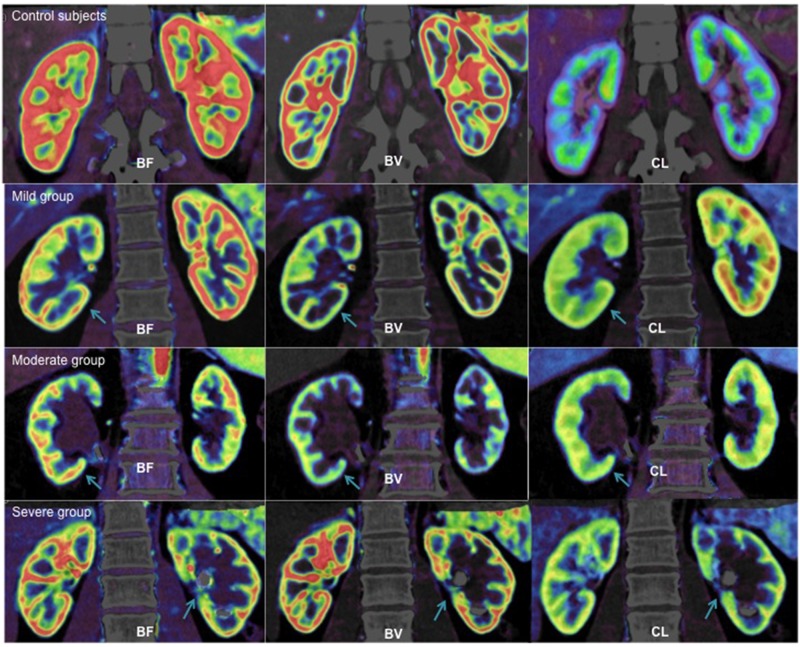
BF, BV and CL maps from control subjects and the three groups of UUO.The perfusions of both kidneys were uniform in control subjects and renal cortex showed an intact red ring. For UUO patients, BF, BV and CL maps showed dilation of collecting system in the obstructed kidney (arrow) and normal contralateral kidney. The renal cortex from obstructed kidney was less continuous and local yellow or blue areas were observed in the perfusion maps. BF, blood flow; BV, blood volume; CL, clearance.